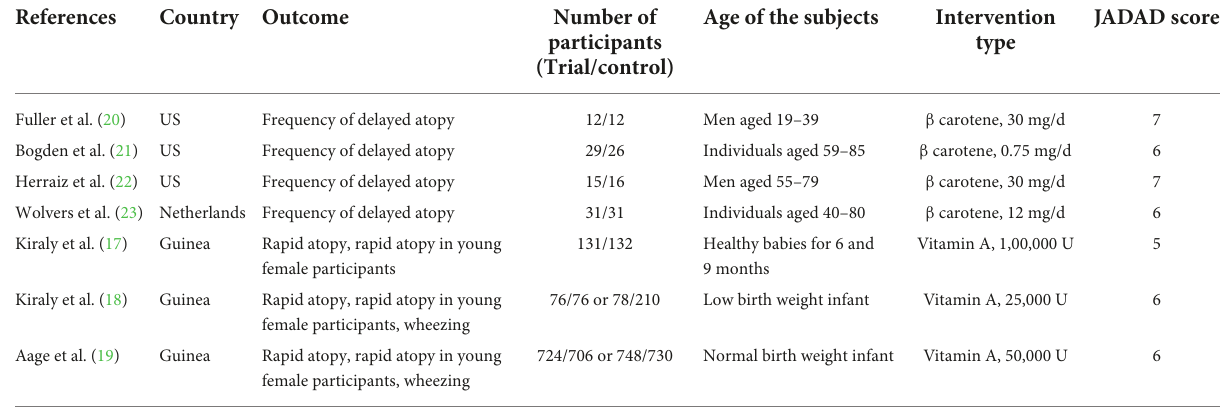
TABLE 1 Characteristics of eligible